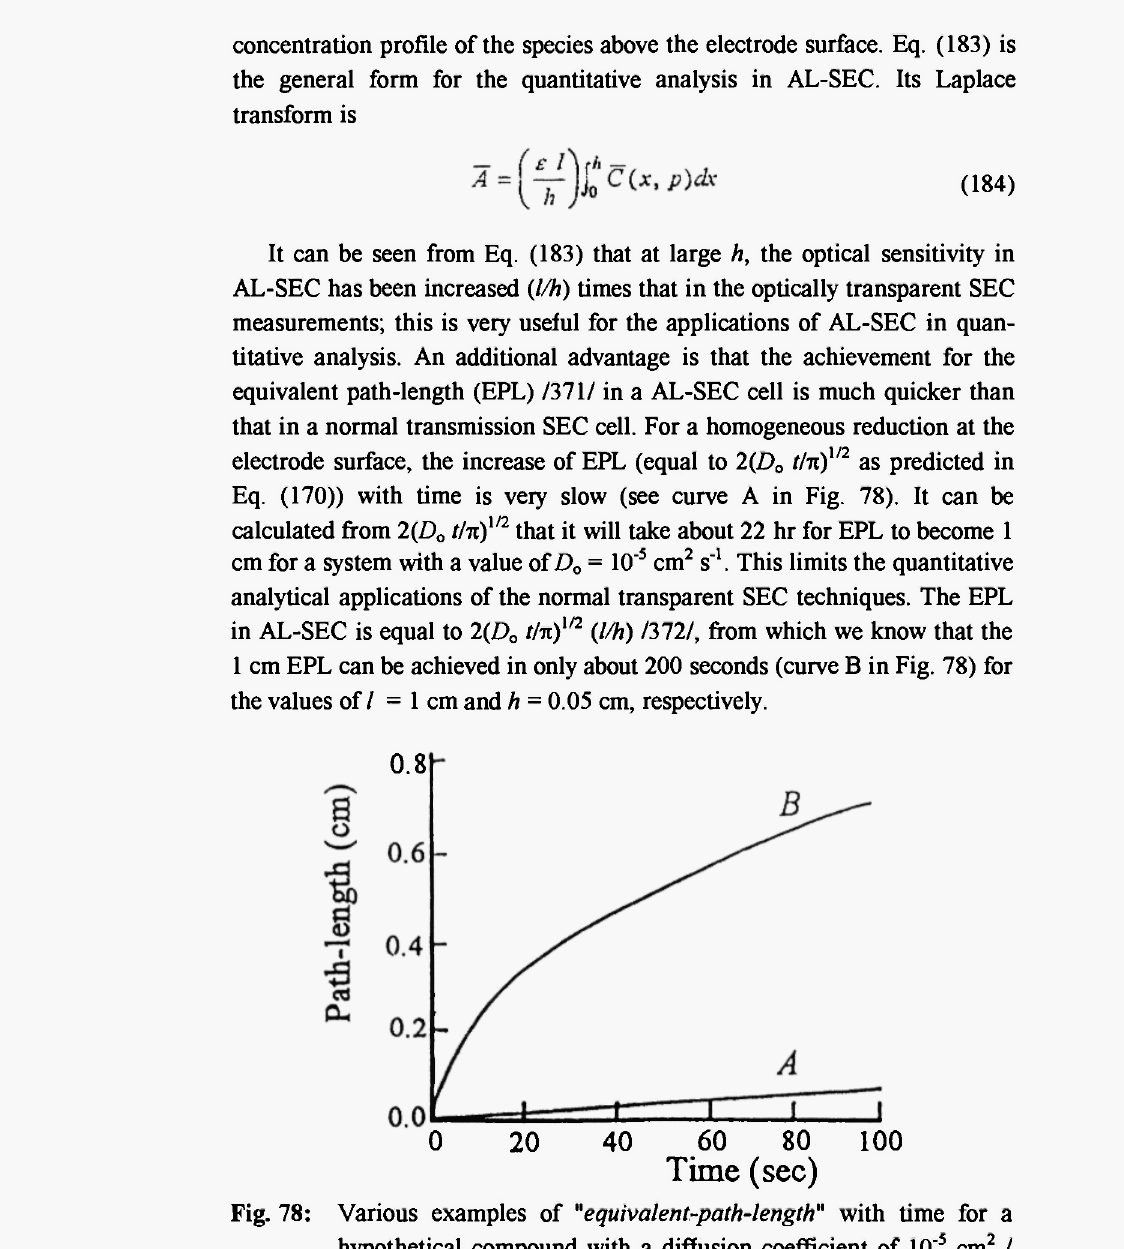
Fig. 78: Various examples of " equivalent-path-length " with time for a hypothetical compound with a diffusion coefficient of 10" 5 cm 2 / sec in an optically transparent SEC cell (A) and a parallel incident SEC cell (B). (From Ref.